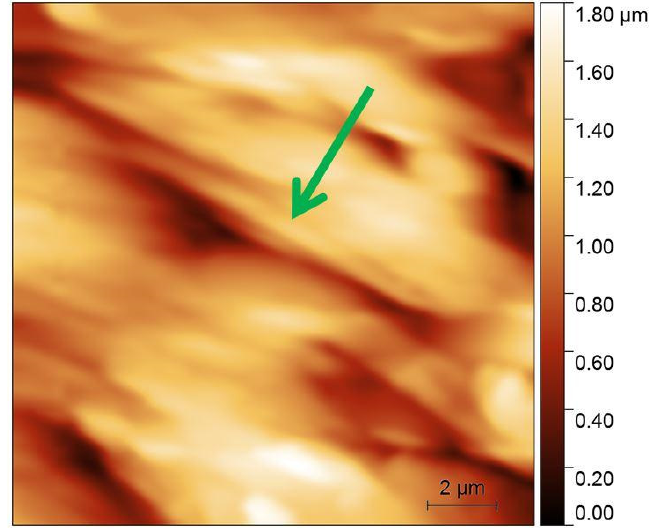
Figure 7. AFM pictures of PEEK surface before modification. Arrow points onto the same surface detail as in the next picture.